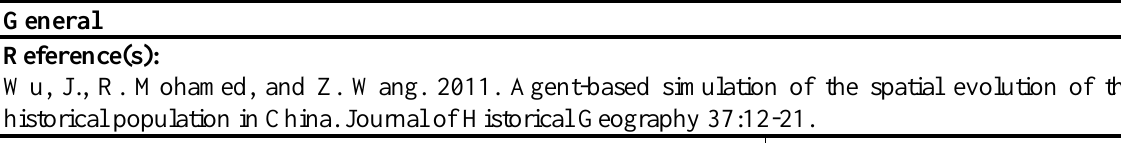
Table A1.15 Standardized protocol for the ABM described by Wu et al.